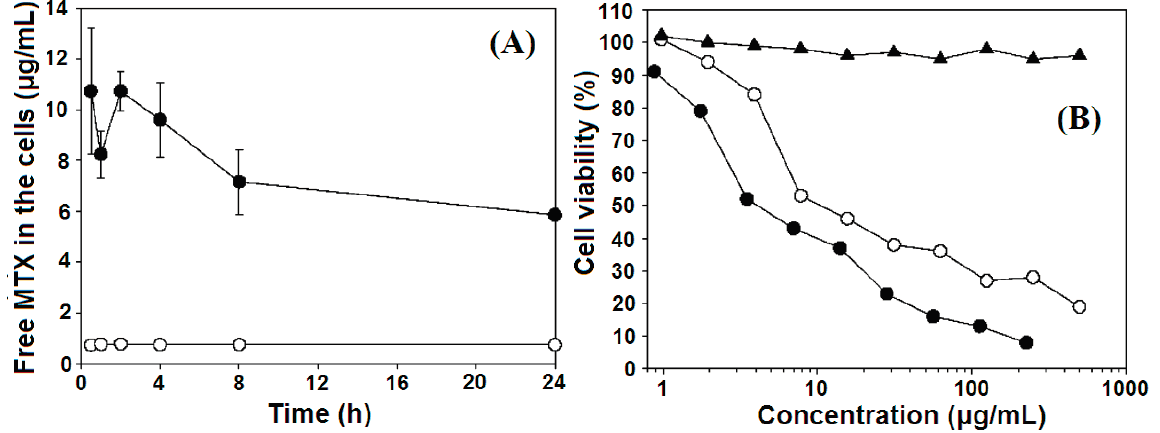
Figure 13. Cellular accumulation of free MTX molecules in MNNG/HOS cells treated with either MTX ( ○ ) or MTX–LDH ( ● ). ( A ) Cell viability/cytotoxicity of MNNG/HOS cells treated with LDHs ( ▲ ), MTX ( ○ ), and MTX–LDH ( ● ), as monitored by trypan blue exclusion, with respect to drug concentration ( B ). Reprinted with permission from [50] (Copyright 2006 American Chemical